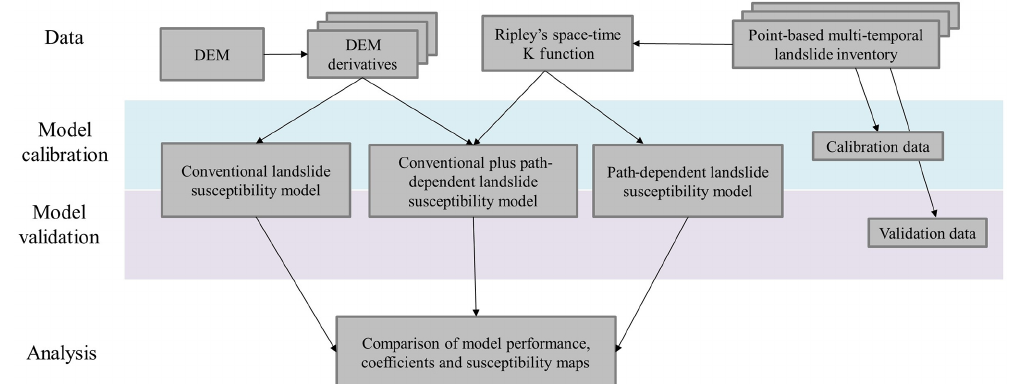
Figure 3. Flowchart of methods.